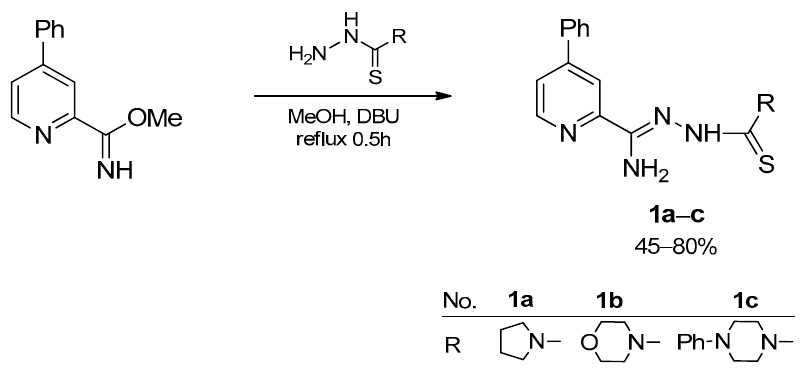
Figure 2. Synthesis of compounds 1a – c .